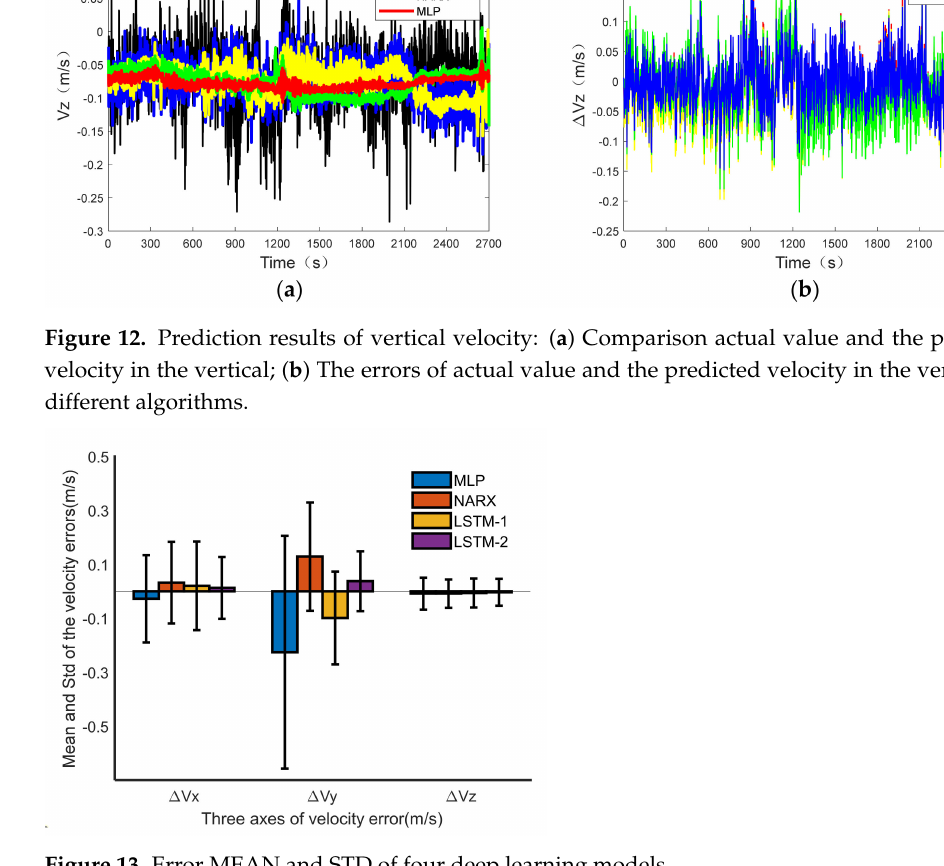
Figure 13. Error MEAN and STD of four deep learning models.